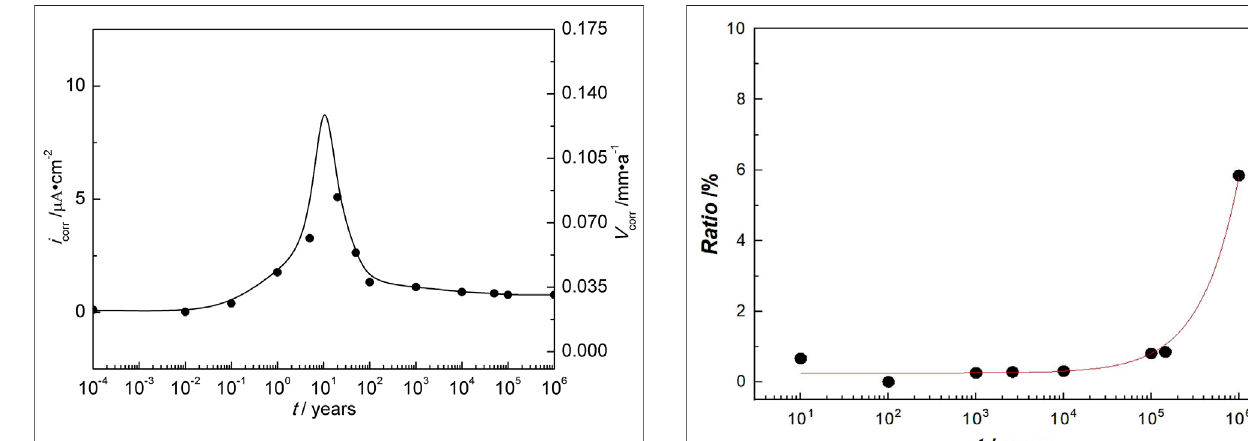
FIGURE 10 | Estimated corrosion rate of Q235 steel in deep geological disposal in Beishan area of China. TABLE 4 | Total amount of charge for hydrogen charging of carbon steel at different disposal periods under free corrosion conditions.